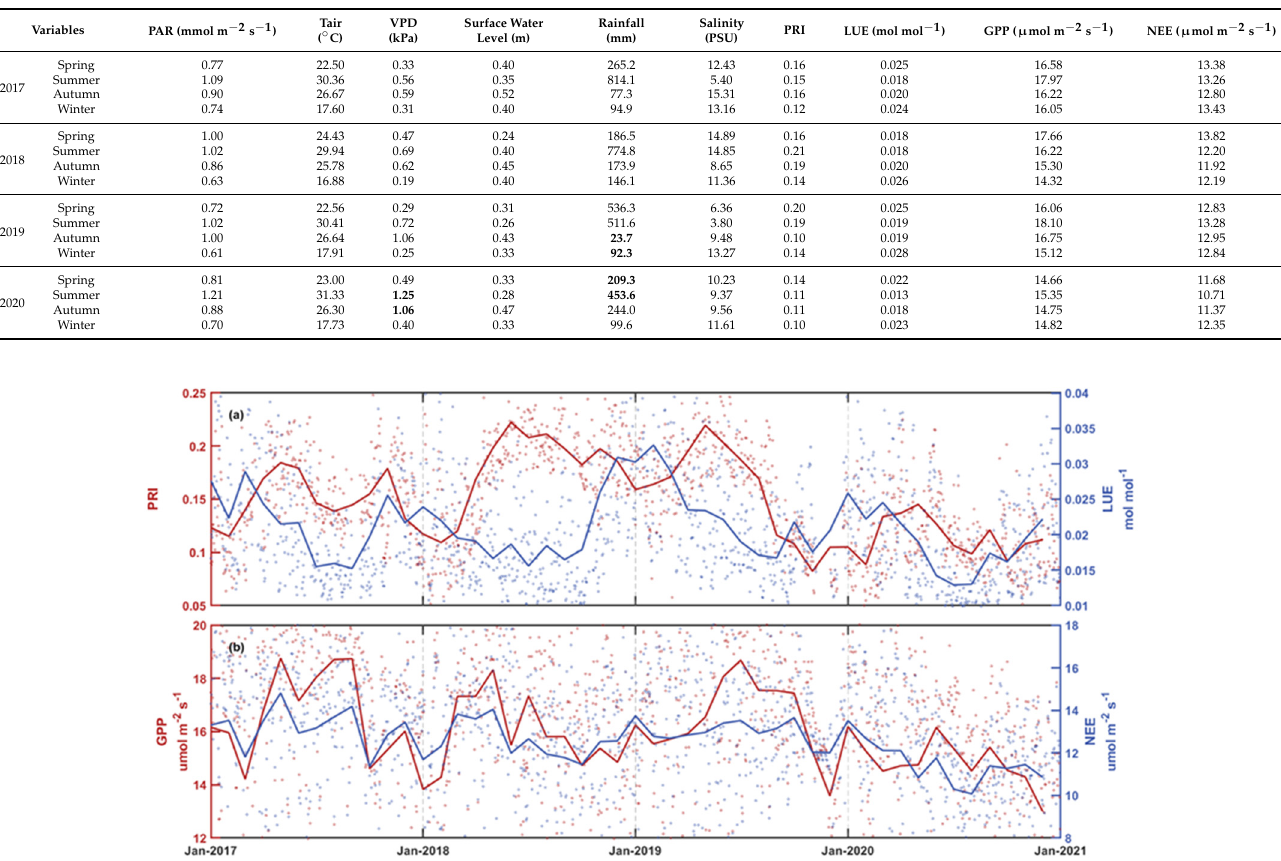
Figure 3. Seasonal and annual variations in daytime mean values of spectral and carbon-related variables from January 2017 to December 2020. Dots indicate daily values and lines indicate corresponding monthly mean values. PRI = photochemical reflectance index; LUE = light use efficiency; GPP = gross primary production; NEE = net ecosystem exchange.